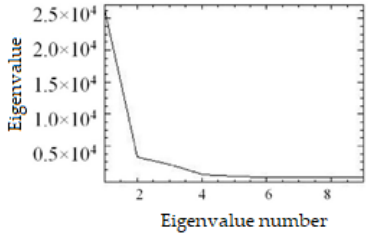
Figure 10. The PCA eigenvalue plot for the VNIR+ SWIR bands of ASTER